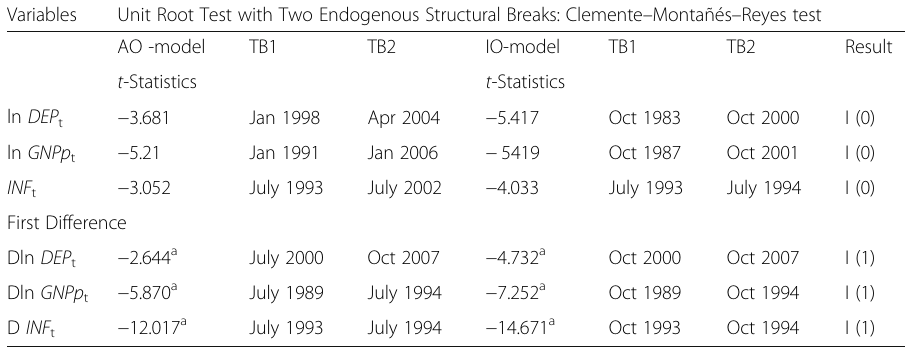
Table 3 Unit root test with two endogenous structural breaks: Clemente – Montañés – Reyes test Variables